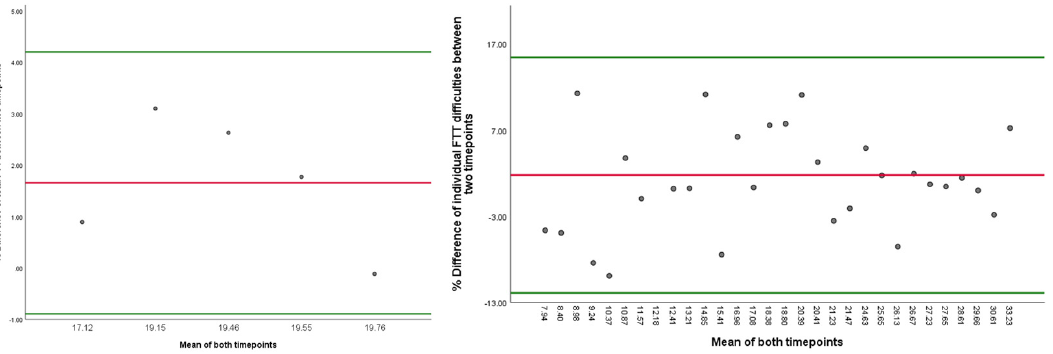
Figure 3. Bland–Altman plots depicting the reproducibility of total FTT time and individual FTT difficulties. Legend: FTT − Fitts’ Tapping Task. Left − absolute difference in Fitts’ Tapping Tasks within the people with multiple sclerosis over 1 ‐ week follow ‐ up, Right − percent difference in Fitts’ Tapping Tasks within the people with multiple sclerosis over 1 ‐ week of follow ‐ up. Each dot repre ‐ sents the difference between the two timepoints over 1 ‐ week. The green lines represent the lower and upper 95% confidence intervals and the red line represents the mean value.